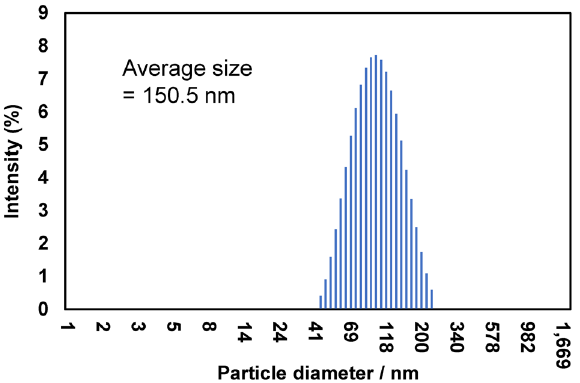
Figure 7. Nanosized particle diameter distribution of 15 days-AOP degraded PP sample in the